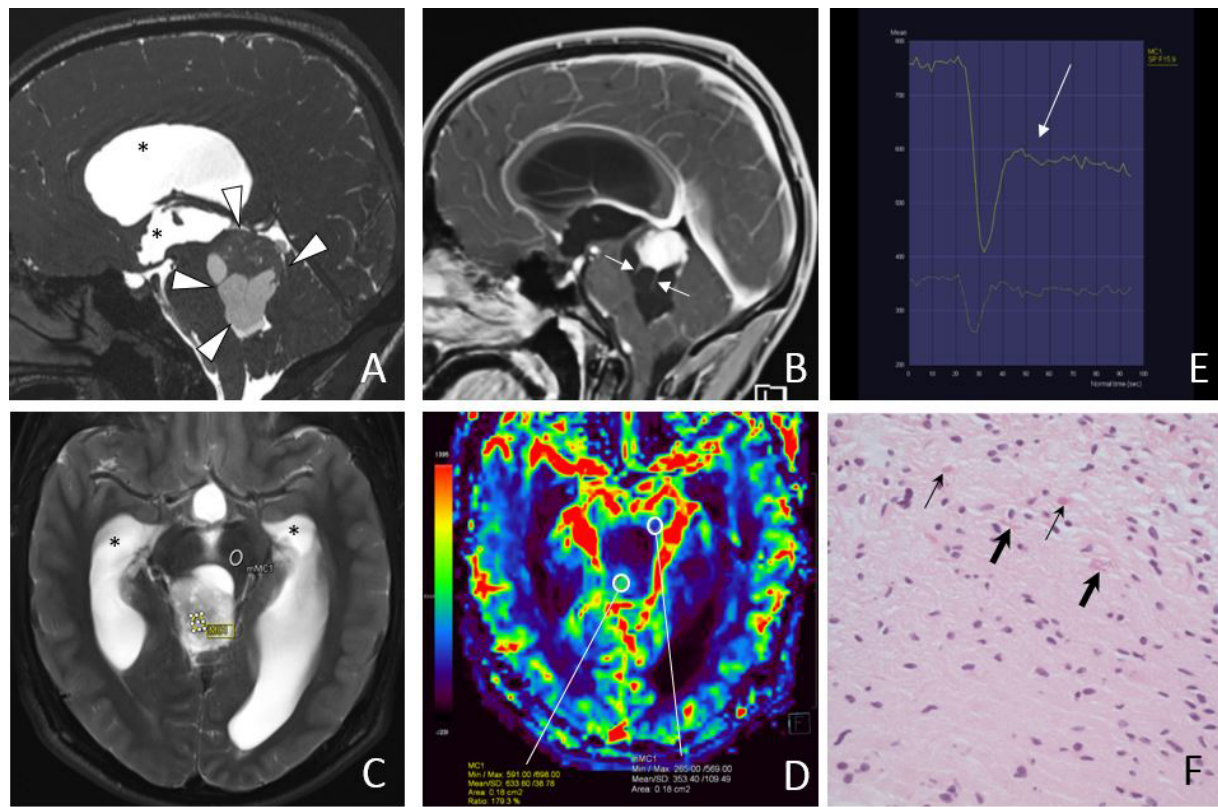
Fig.4. Case4. aPAcausingobstructivehydrocephalus. Sagittalplanereconstructed3Dsteady-state“CISS”(A)andpost-gadolinium3DT1fastGRE(B)images demonstrate a solid-cystic mass (arrowheads in A) with intense contrast enhancement (arrows in B), originating from the quadrigeminal plate, and causing aqueduct compression with triventricular hydrocephalus. The solid component of the mass shows inhomogeneous T2 hyperintensity (C – axial T2 TSE image), and moderately increased rCBV (1.79) as compared to the normal WM (ROIs D – see also ROIs in C). The corresponding perfusion time-signal curve (E, arrow) shows only partial signal recovery after first pass contrast enhancement, consistent with a fenestrated brain-tumor-barrier (please see discussion section for more details). The histological findings (F) demonstrate a densely, fibrillary texture with bland cells, some Rosenthal fibers (thick arrows) and eosinophilic granular bodies (thin